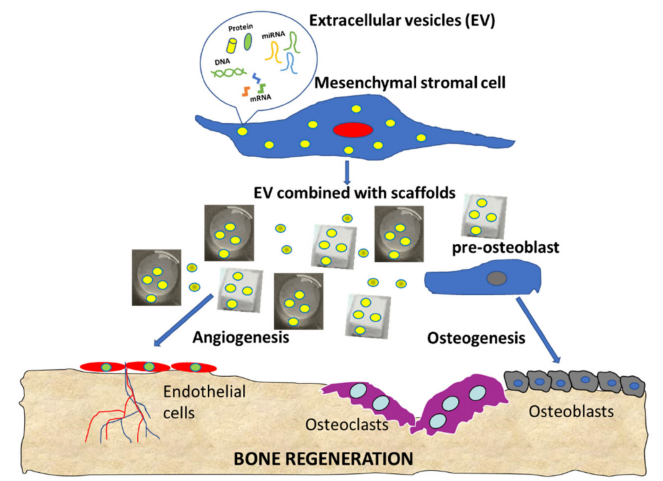
Figure 3. Summary cartoon of EV functions in bone